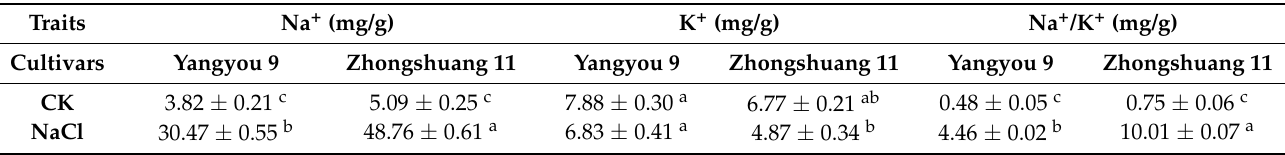
Table 1. Na + , K + , and Na + /K + ratio in shoots under salt stress during the early seedling stage. Traits Na + (mg/g) K + (mg/g) Na + /K + (mg/g) Cultivars Yangyou 9 Zhongshuang 11 CK 3.82 ± 0.21 c NaCl 10.01 ± 0.07 a Data are the mean ( ± SE) of three replicates. Letters (a, b and c) on vertical bars represent significant differences between cultivars and treatments according to Duncan’s multiple range test (DMRT) at p < 0.05.